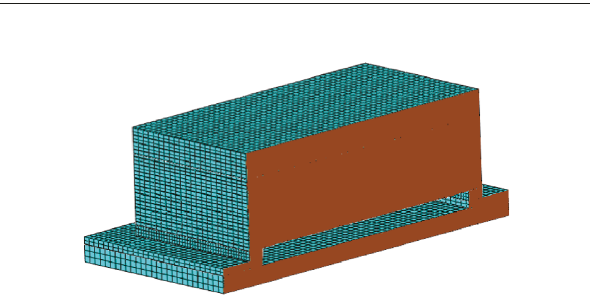
Figure 10: Thermal finite element model.